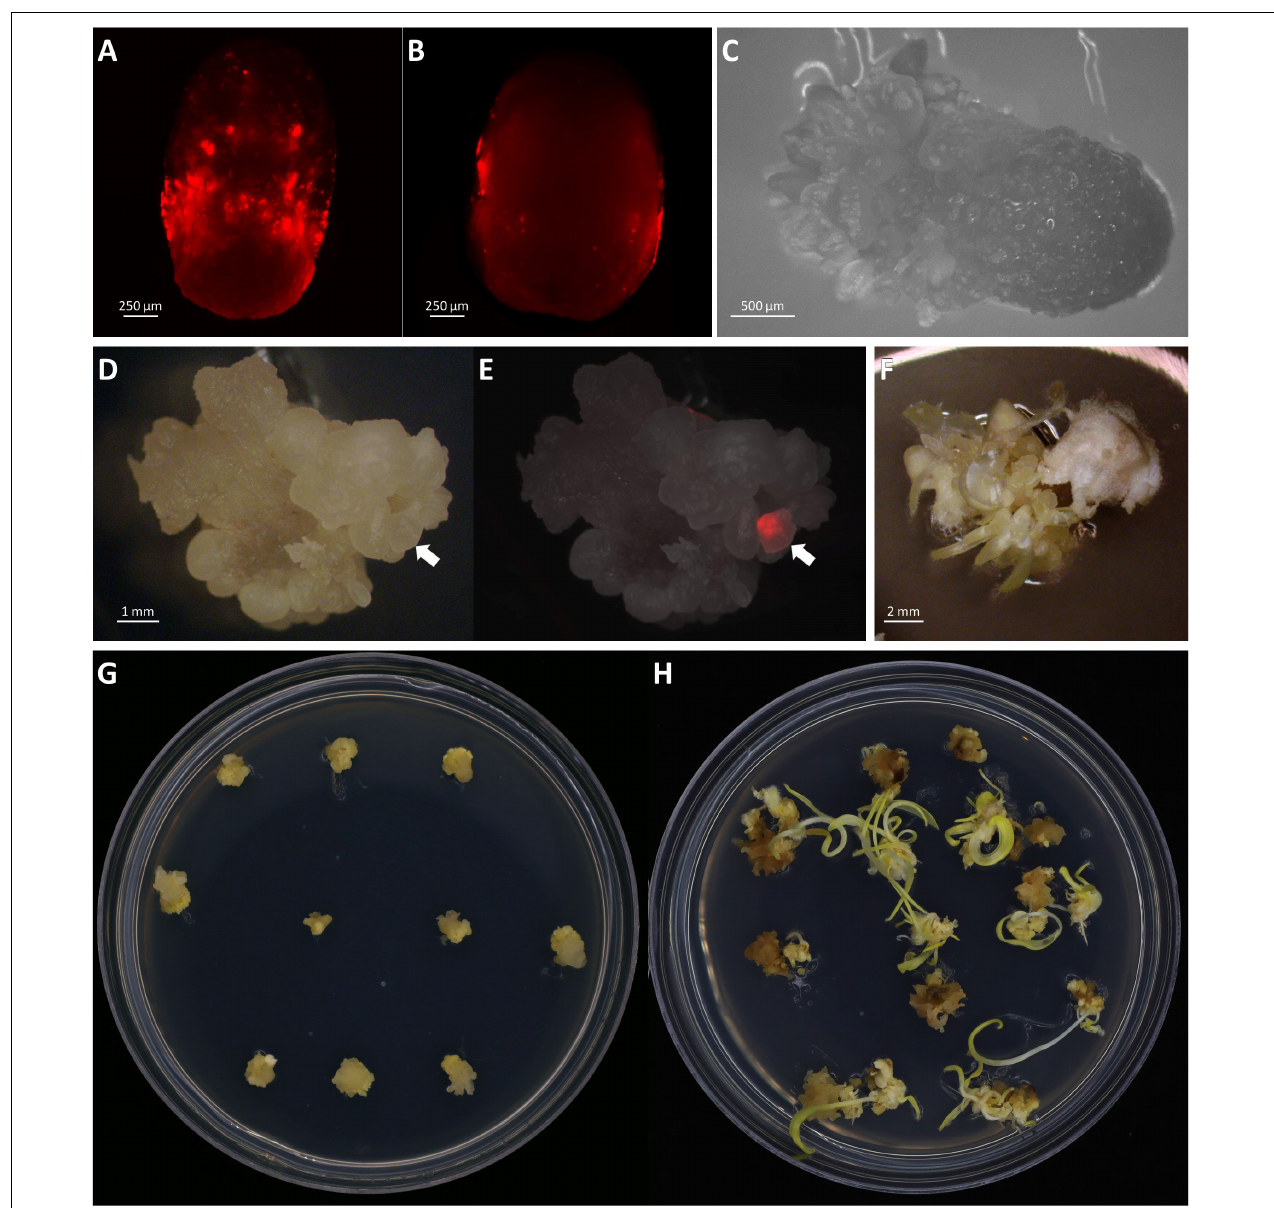
FIGURE 5 | Transient and stable transformation. Observation of transient RFP expression 3 days post-infection on the middle of the scutellum (A) or the side of the embryos (B) . (C) Somatic embryogenesis on embryo scutellum side, 8 days post-infection in bright field. Observation of stable transformation and callus formation of maize embryo under bright field (D) and RFP field overlayed (E) . The arrows indicate callus with the RFP expression. (F) Tentacle-like structure on a callus during the maturation stage, 21 days post-infection. Maize callus on the maturation I medium, 18 days post-infection (G) and the maturation II medium, 31 days post-infection (H)